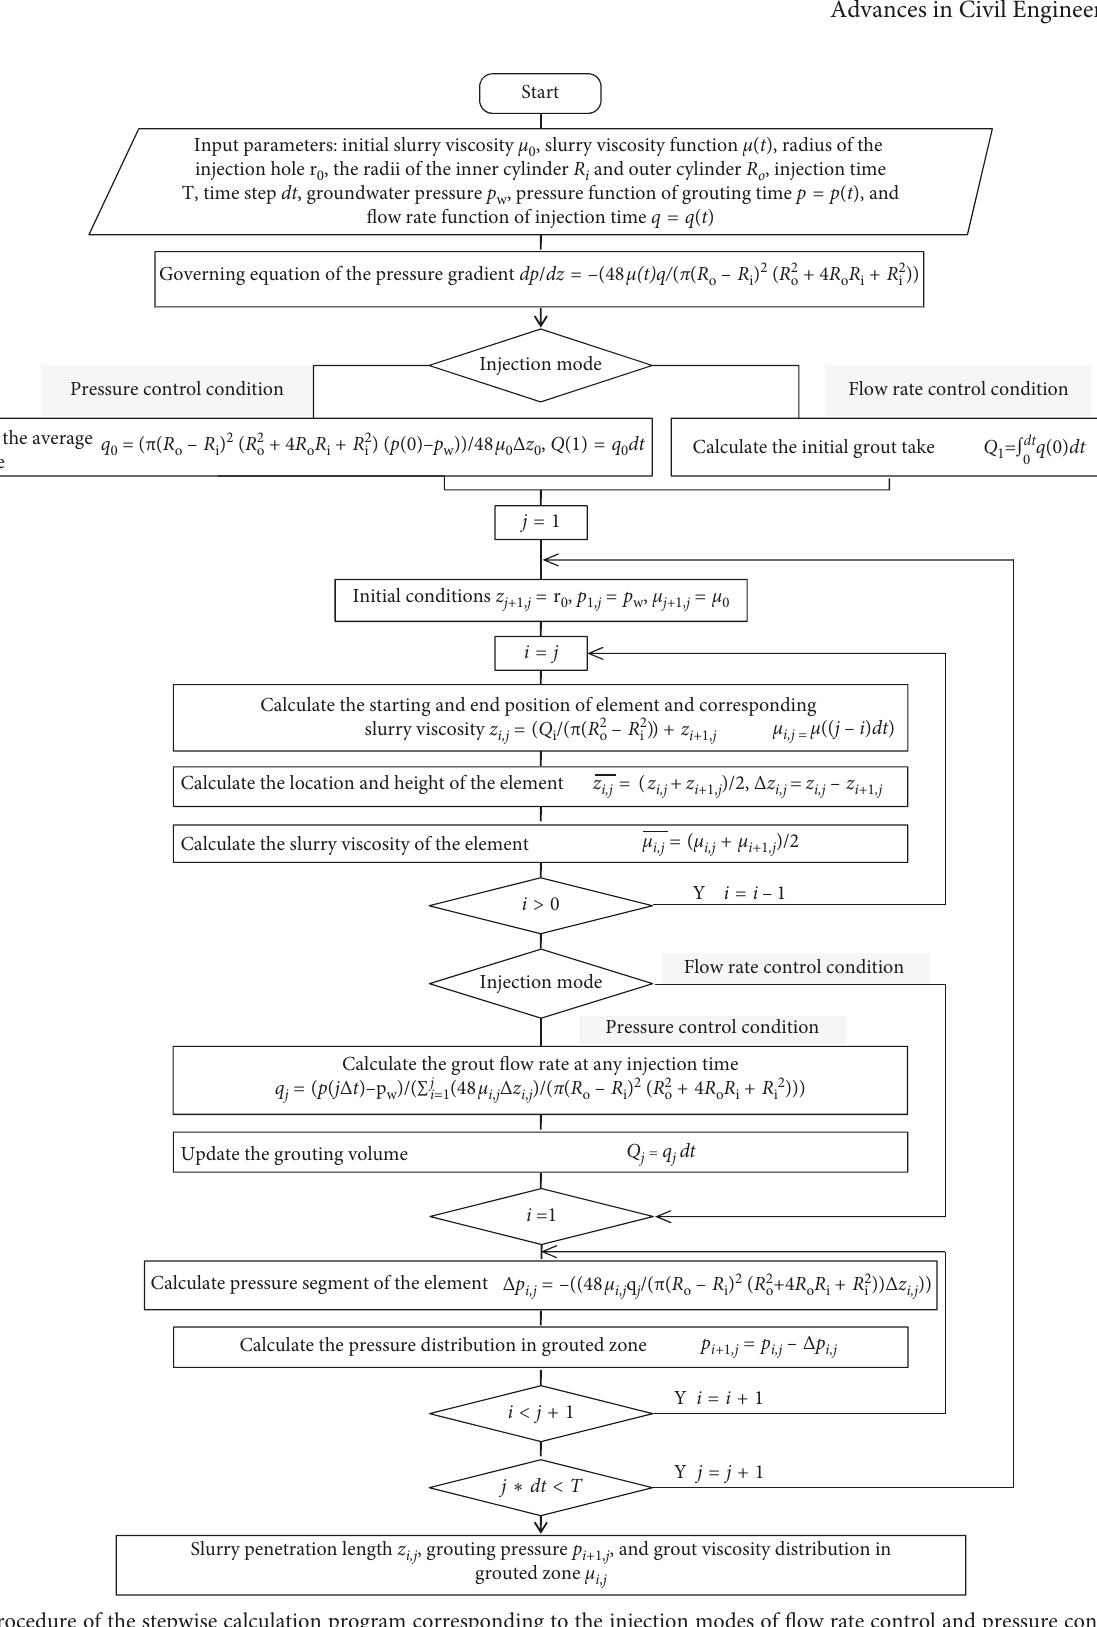
Figure 5: Procedure of the stepwise calculation program corresponding to the injection modes of flow rate control and pressure